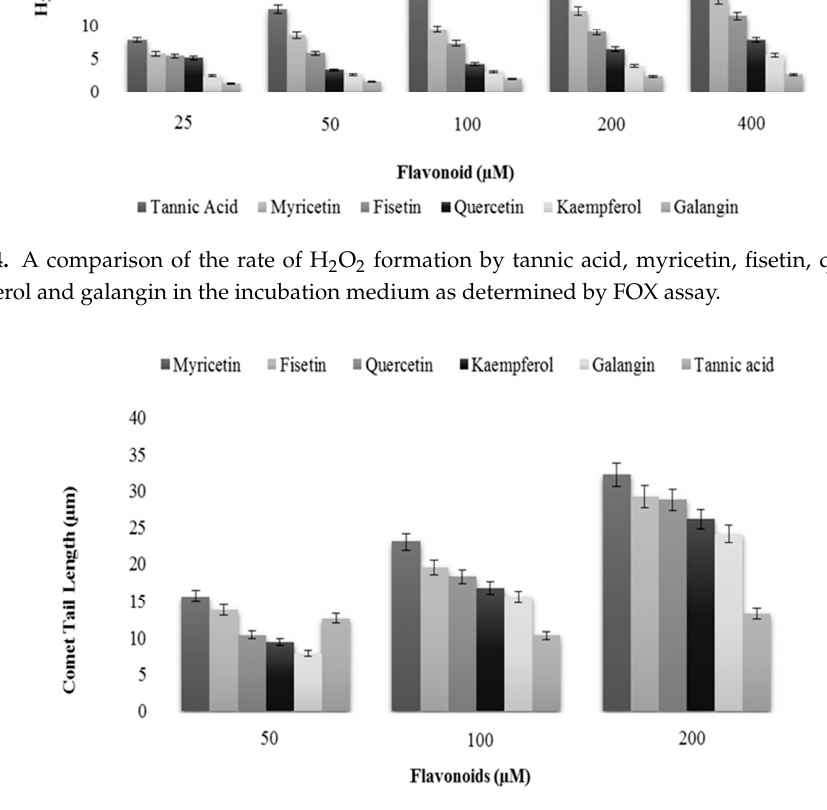
Figure 5. A comparison of DNA breakage induced by tannic acid, myricetin, fisetin, quercetin, kaempferol and galangin in human peripheral lymphocytes as a function of comet tail lengths. Values reported are ±SEM of three independent experiments.